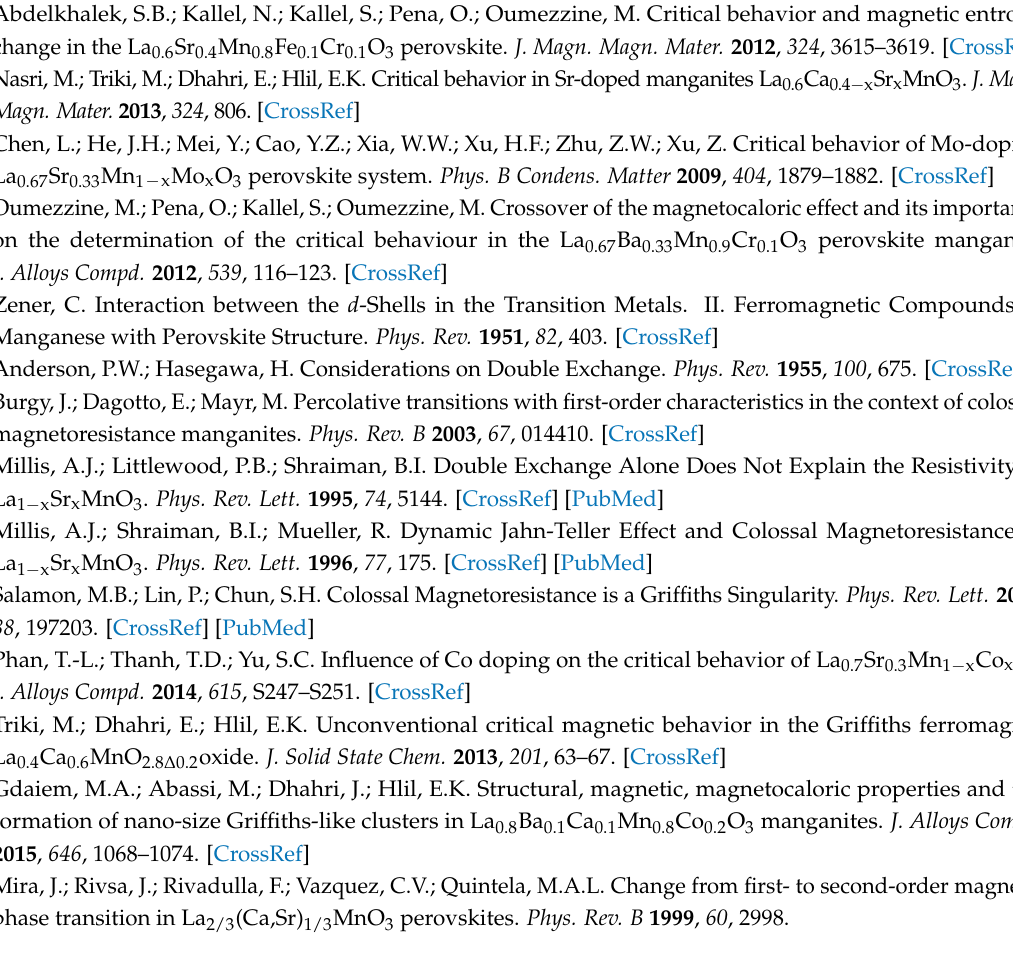
Figure S1: Linear fit of isothermal magnetic curves at T = T C = 181 K, 176 K and 173 K for La 0.8 Ca 0.2 Mn 1 − x Co x O 3 with x = 0.1, 0.2 and 0.3, respectively, Figure S2: Linear fit of magnetic entropy change curves at T C = 181 K, 176 K and 173 K for La 0.8 Ca 0.2 Mn 1 − x Co x O 3 with x = 0.1, 0.2 and 0.3,